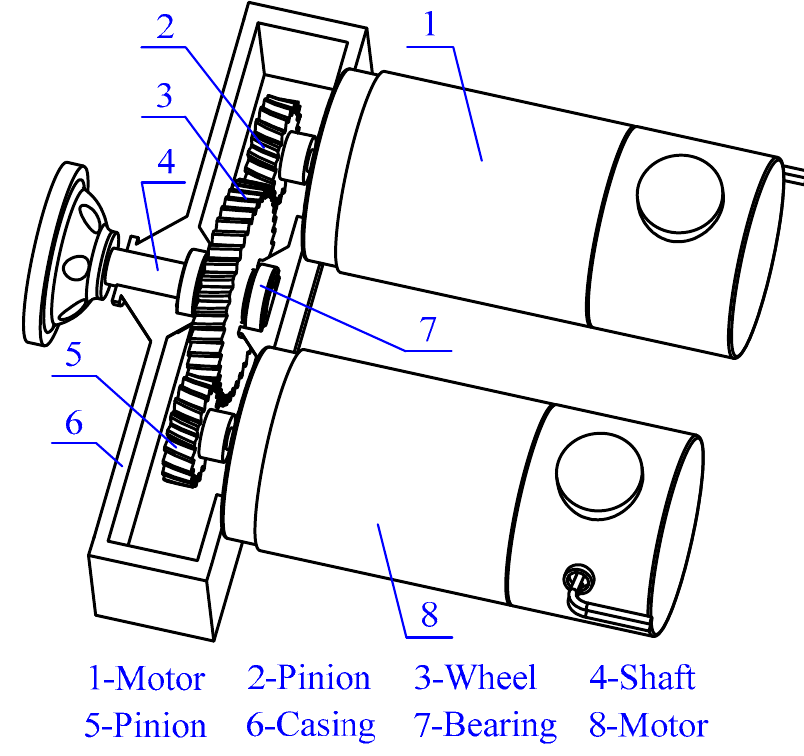
Figure 1. Structure of DMDS.